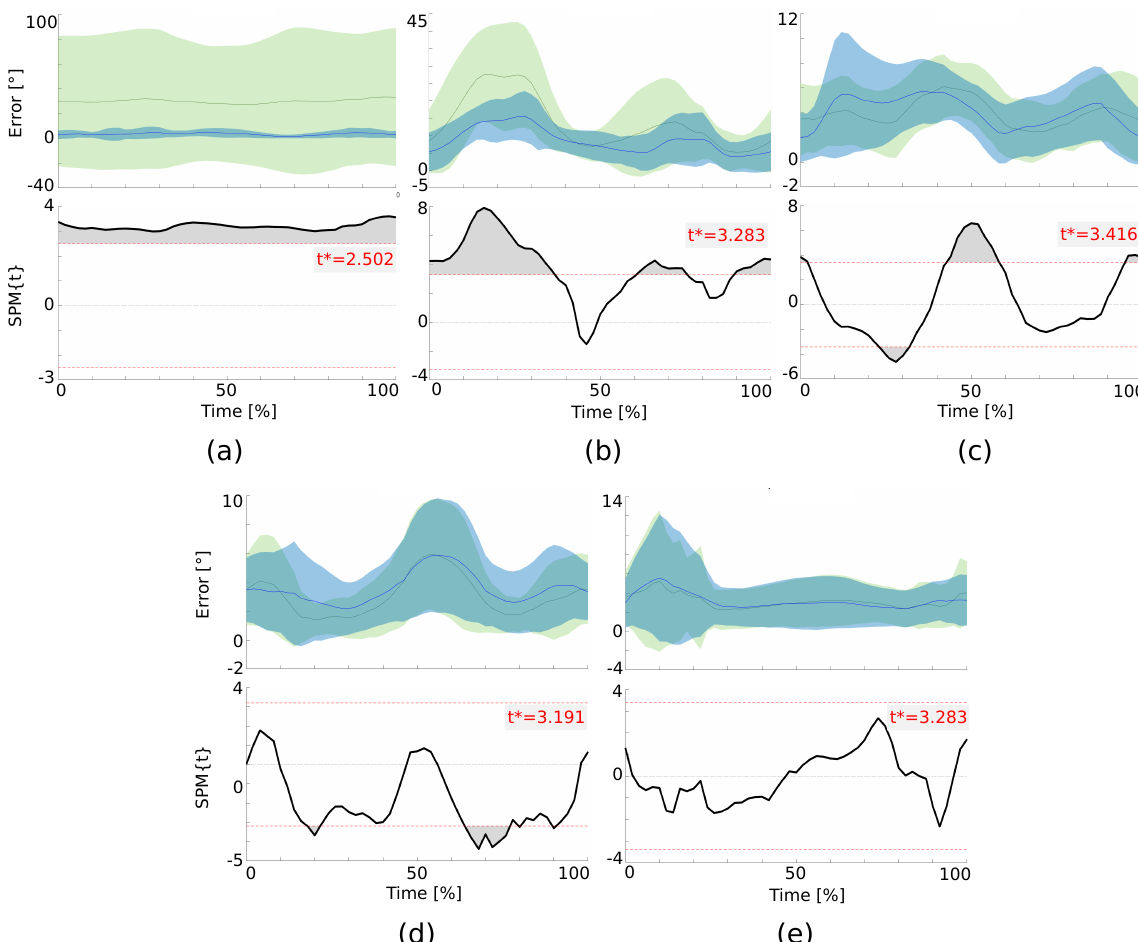
Figure 6. Representative results obtained with the paired t-test statistical parametric mapping (SPM). The top figures show descriptive statistics for each motion (Mean ± 1 SD error cloud from between-subject variability) when the CEKF’s covariance matrices are optimized (green) and when classical methods are used to tune them (blue). Bottom figures show the most frequent inferences. The thick black line depicts the test statistic continuum or SPM{t}. The red horizontal dashed lines illustrate the critical t* based on α = 0.05. All areas outside the dashed red lines (grey) represent a p-value inferior to 5%. ( a ) is the angle θ 14 for task 1, ( b ) the angle θ 4 of task 1, ( c ) the angle θ 5 of task 4, ( d ) the angle θ 5 of task 2, and ( e ) is the angle θ 9 of task